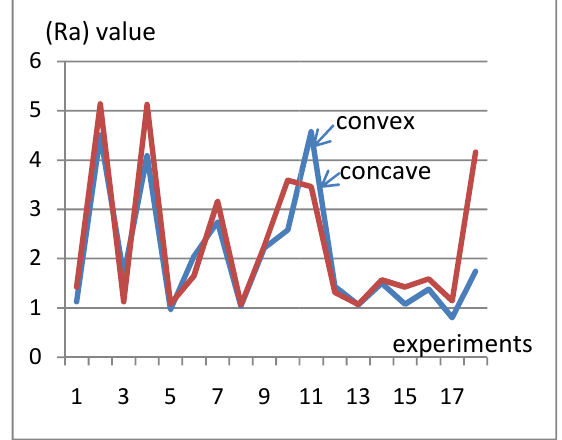
Fig. 4. The model of the work. Fig. 5. Shown the convex and concave The results obtained for the values of the The results obtained for the values of the roughness shown in table (3) found in convex area roughness shown in table (3) found in convex area less than concave area as the diagram (1) less than concave area as the diagram (1) 5. Prediction by (ANFIS) described below. adaptive network based fuzzy inference Table 3, The roughness value in convex and concave areas he roughness value in convex and concave areas Ra.1